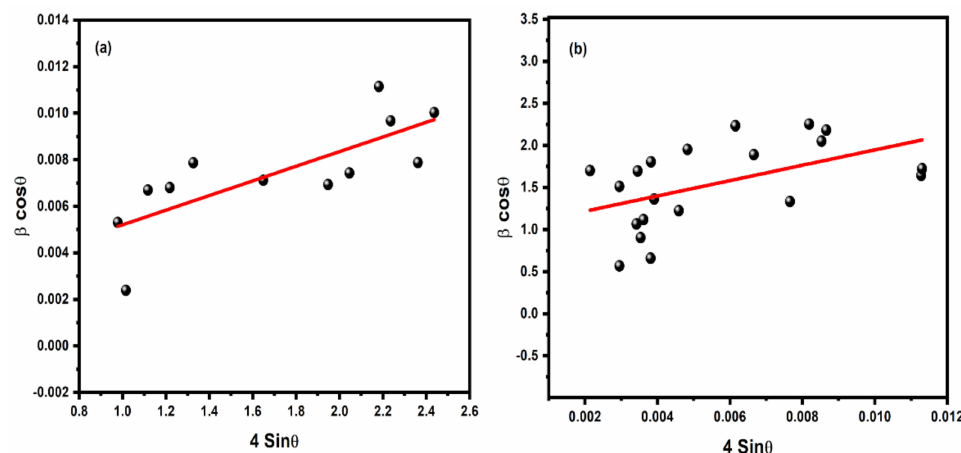
Figure 3. Williamson-Hall (W-H) analysis for ( a ) CuO and ( b ) Zn-doped CuO nanostructures.